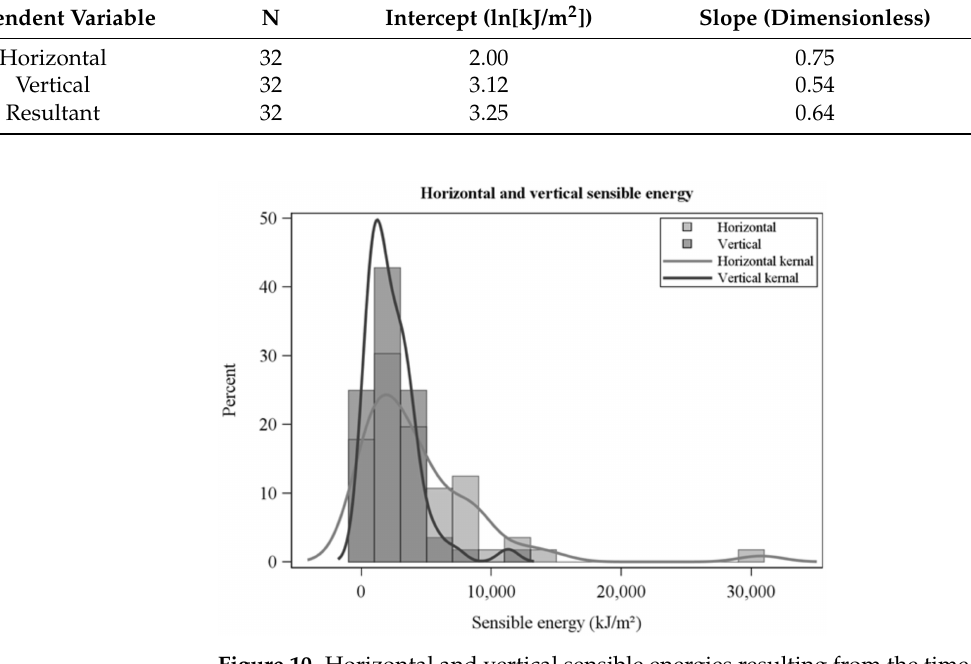
Figure 10. Horizontal and vertical sensible energies resulting from the time-integration of sensible heat fluxes over residence times.